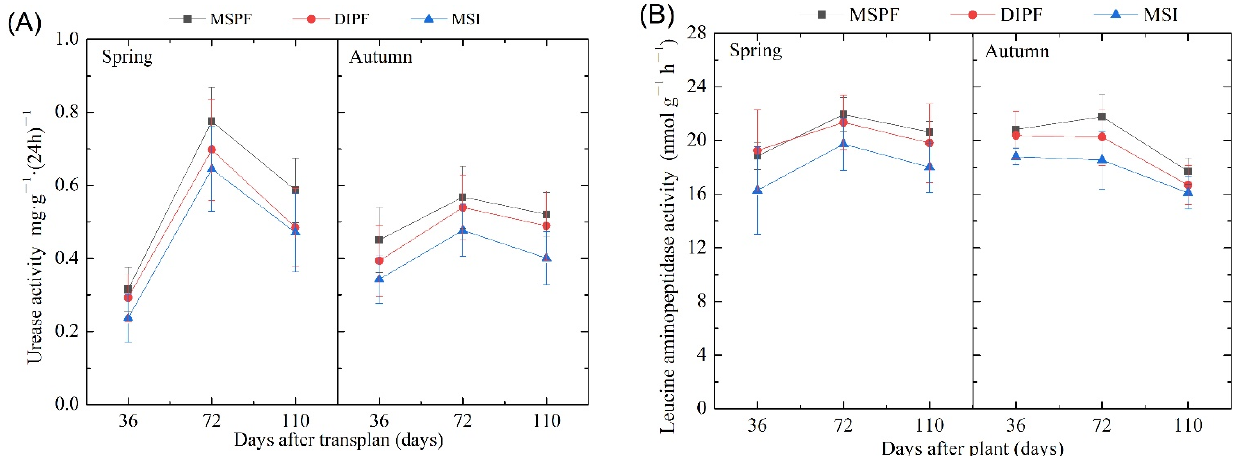
Figure 5. Rhizosphere soil urease ( A ) and leucine aminopeptidase ( B ) activities under different irrigation strategies.